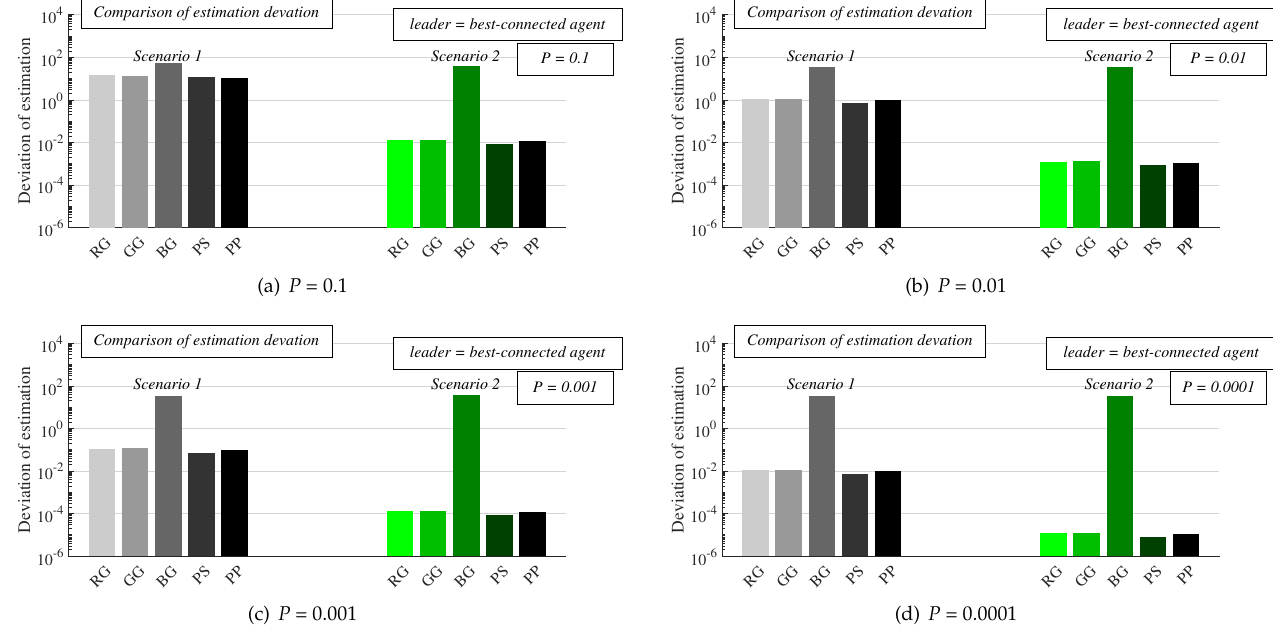
Figure 11. Comparison of the estimation precision of all algorithms in both scenarios for various configurations of implemented stopping criterion—best-connected agent is